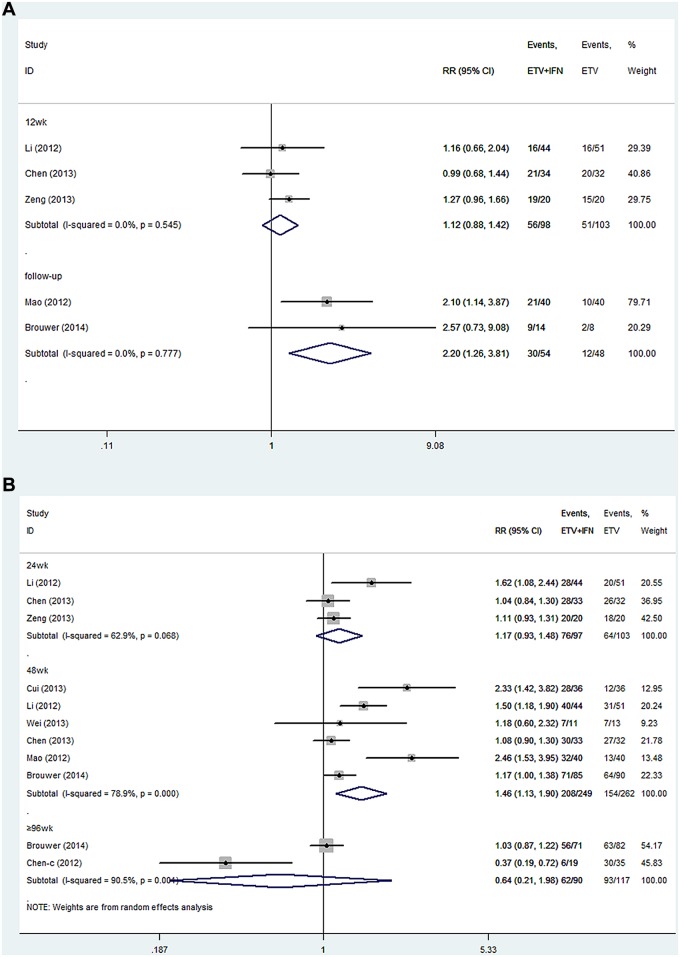
Forest Plot for Undetectable HBV DNA when ETV was used as the Control Group.(A) Forest plot for undetectable HBV DNA based on a fixed-effects model. (B) Forest plot for undetectable HBV DNA based on a random-effects model.